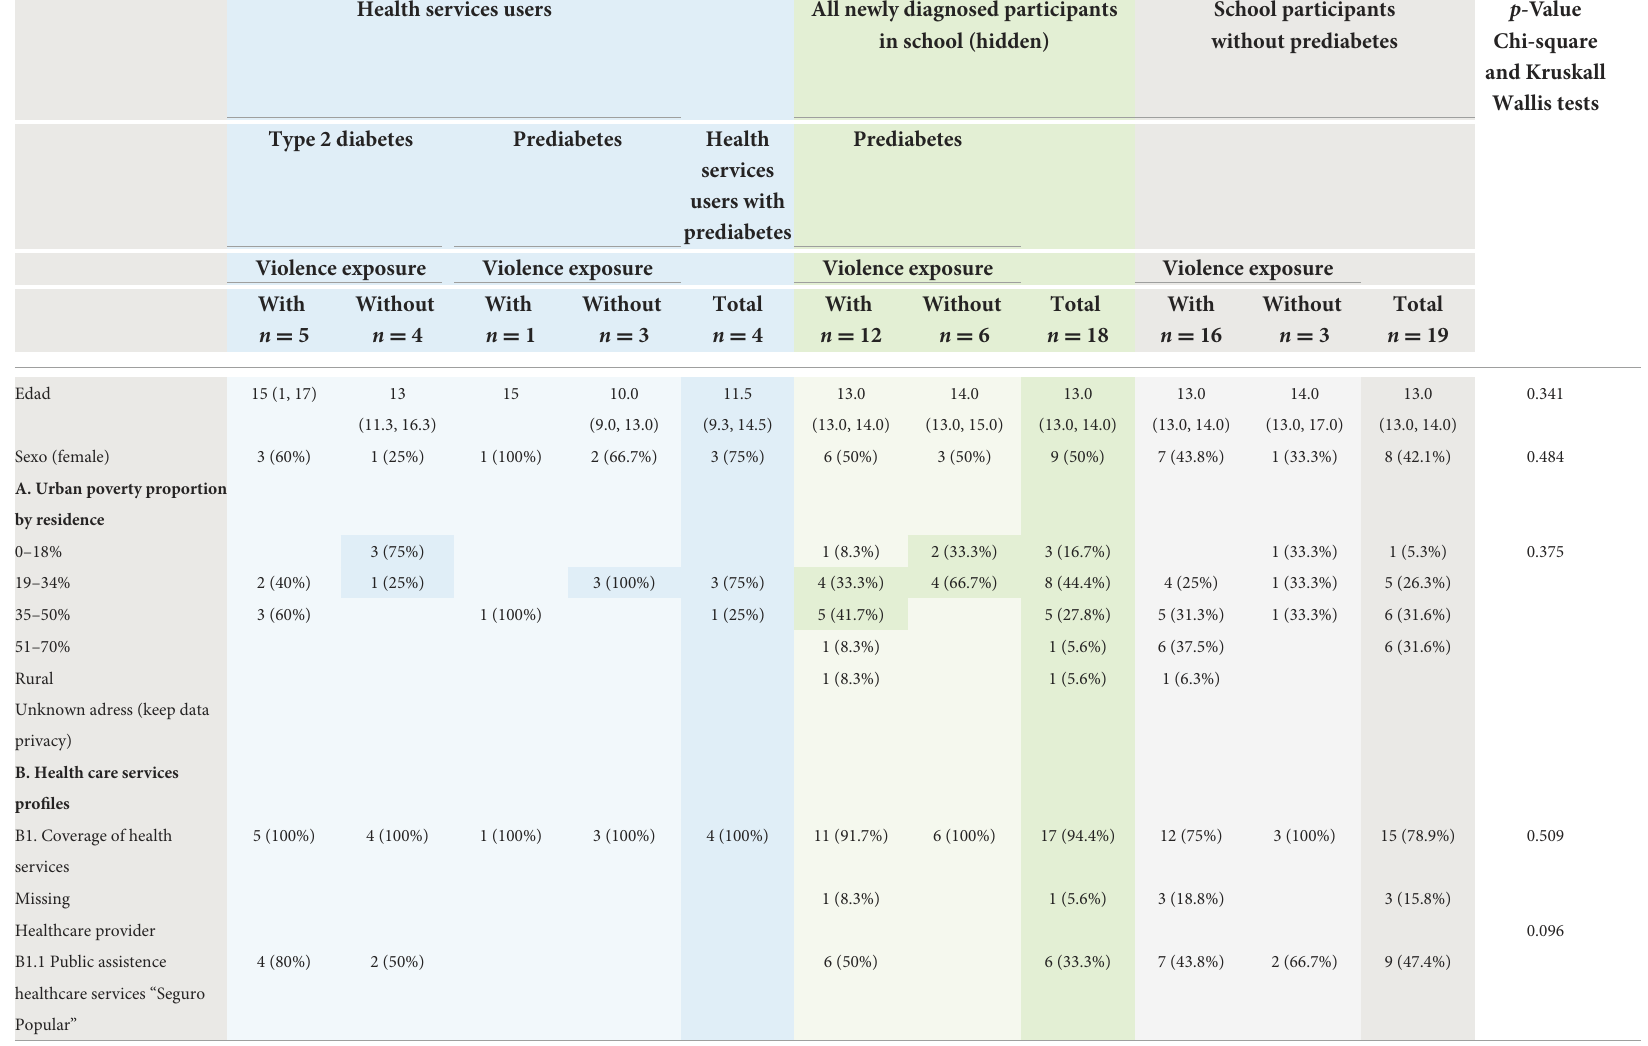
TABLE 3 Comparative analysis of sociodemographic and clinical features of adolescents with prediabetes. Health services users All newly diagnosed participants